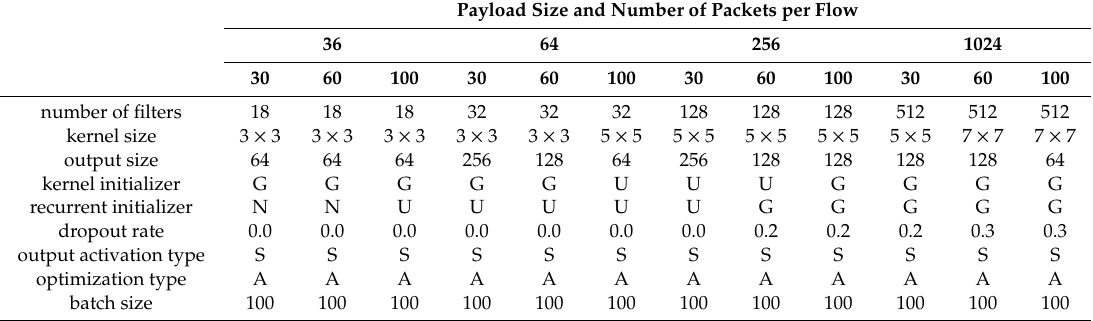
Table 4. The optimal hyper-parameter values for the CNN + LSTM model (U: uniform, N: normal, G: glorot uniform, S: softmax, R: rmsprop, A: